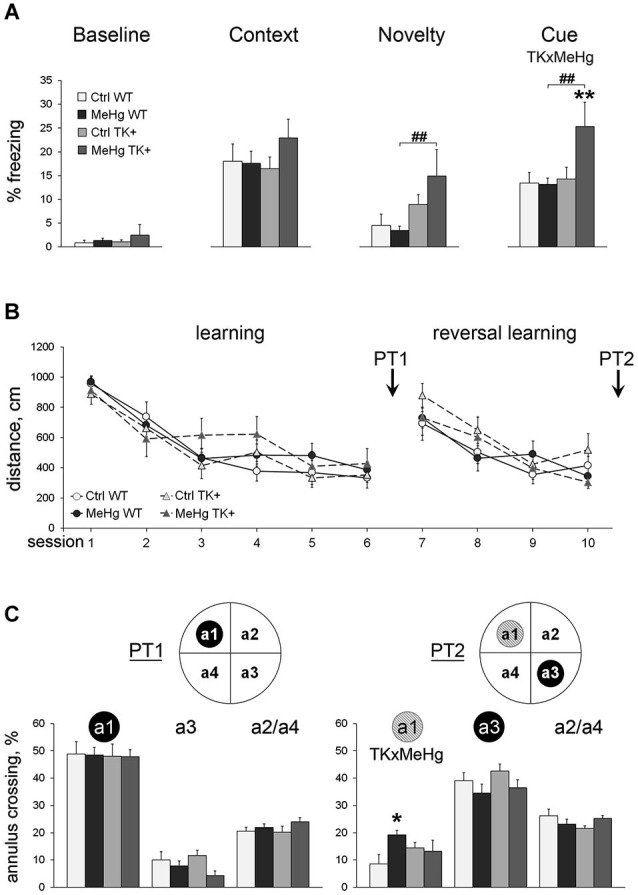
Learning and memory. (A) Fear conditioning: TrkB overexpression enhances generalized anxiety and conditioned cue memory in the MeHg mice. The freezing to the conditioning context was measured before training (Baseline) and next day after training (Context). The unconditioned freezing to the new context (Novelty) and one CS presentation (Cue) was measured after assessment of contextual memory. (B) Morris water maze: the MeHg mice show normal spatial learning throughout 10 sessions and (C) long-term memory during probe trials PT1 and PT2 but impaired reversal spatial memory during PT2. Inserts: schematic presentation of the MWM tank where the trained annuli are shown as the black circles, and the former trained annulus a1 during the PT2 trial is shown as a gray circle. a2/a4, the averaged percentage of crossing of the a2 and a4 annuli that have been never trained. Two-way ANOVA analysis: TK × MeHg significant interaction of the factors TK and MeHg. Post hoc Tukey’s group comparisons: * P < 0.05, ** P < 0.01 MeHg vs. respective Ctrl group; ##
P < 0.01 TK+ vs. respective WT group. N = 9 Ctrl WT, 12 MeHg WT, 12 Ctrl TK+ and 7 MeHg TK+ mice.